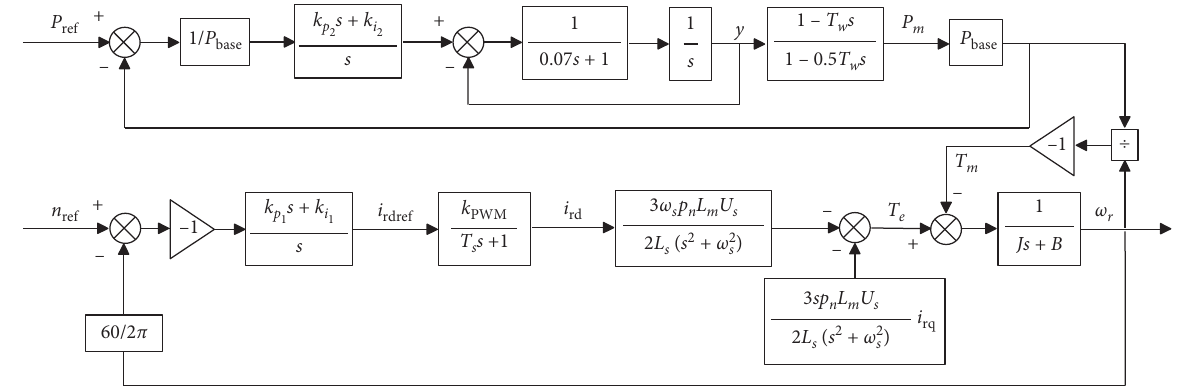
Figure 22: Control block diagram of the speed priority control strategy in the generating mode.